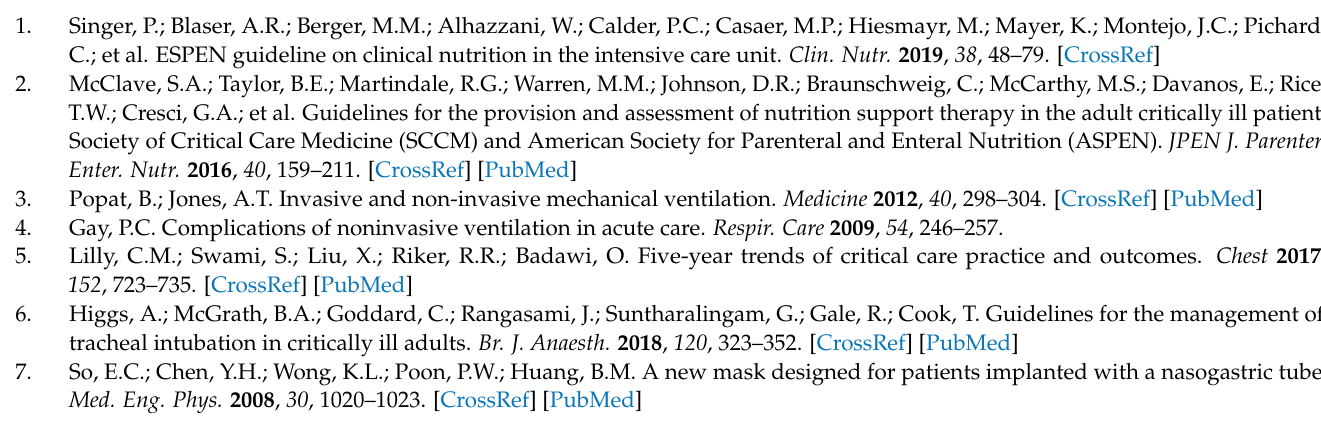
Table S2: ELSEVIER—Scopus Search Strategy; Table S3: Web of Science Search Strategy; Table S4: Google Scholar Search Strategy; Table S5: Data-Extraction